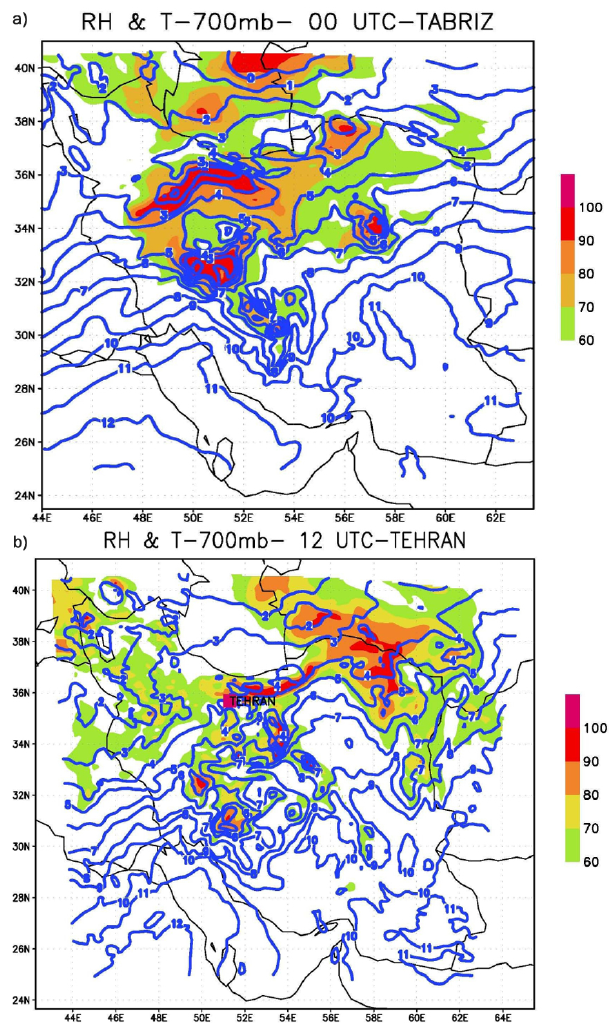
Fig. 10. (a) Temperature and relative humidity at 700hPa on 30 April 2009 for Tabriz station. (b) Temperature and relative hu- midity at 700hPa on 30 April 2009 for